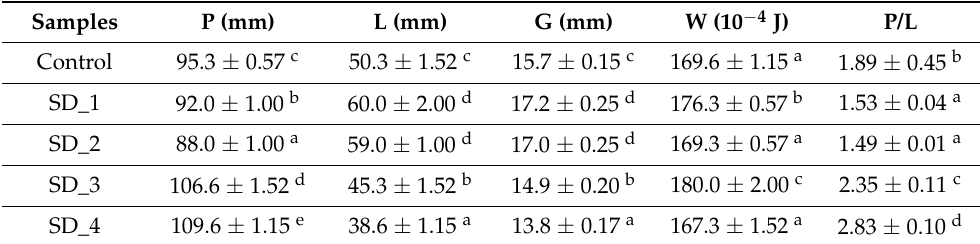
Table 2. Alveograph rheological properties of dough samples with different levels of dry sourdough (SD)